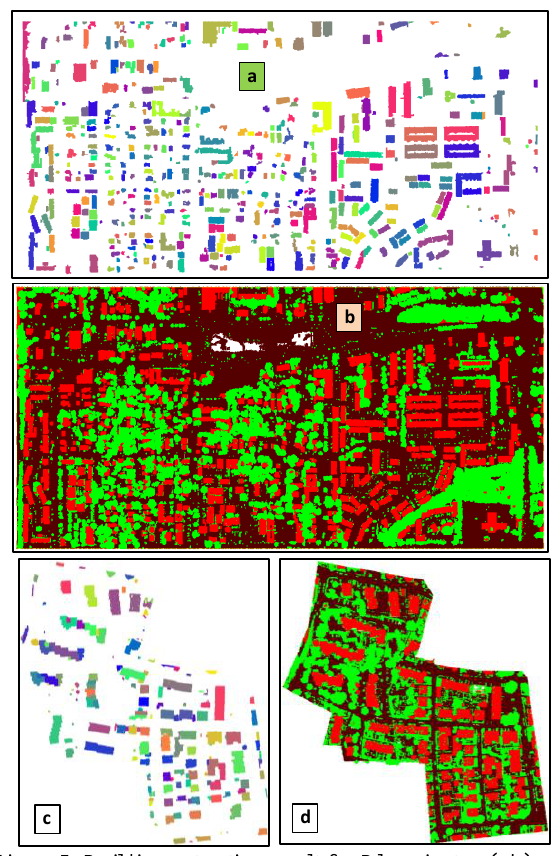
Figure 5. Building extraction result for Bloomington (a,b) and Vaihingen (c,d) datasets. (a,c): Points randomly colored for each individual building. (b,d): Points depicted as ground (brown), off-ground non-building (green), and building (red)